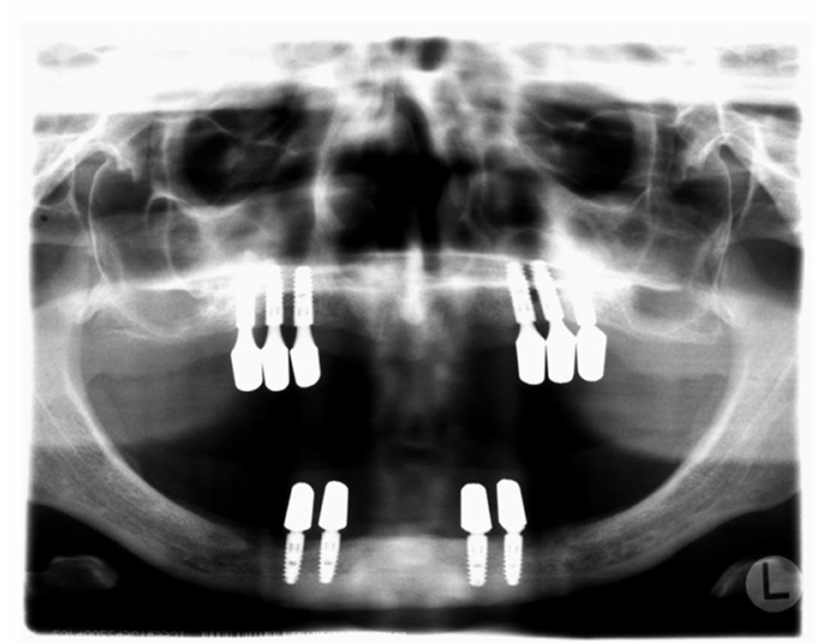
Figure 2. Patient 1 (panoramic radiograph performed in 2010): 10 Ankylos ® implants (2.5 years in